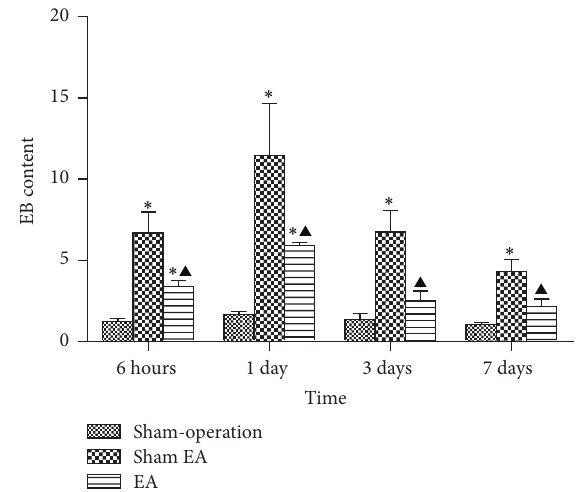
Figure 2: Effects of EA on BBB permeability after ICH in rats (mean ± SD, 𝑛 = 6 ). Evans Blue leakage experiments for determining BBB permeability after acute ICH in rats in 4 subgroups at 6 h, 24 h, 3 d, and 7d. One-way analysis of variance (ANOVA) was used for multiple group experiments comparisons and followed by Dunnett test for comparison of two groups within the multiple groups. ∗ 𝑃 < 0.05 , compared with Sham-operated group. 󳵳 𝑃 < 0.05 , compared with Sham EA